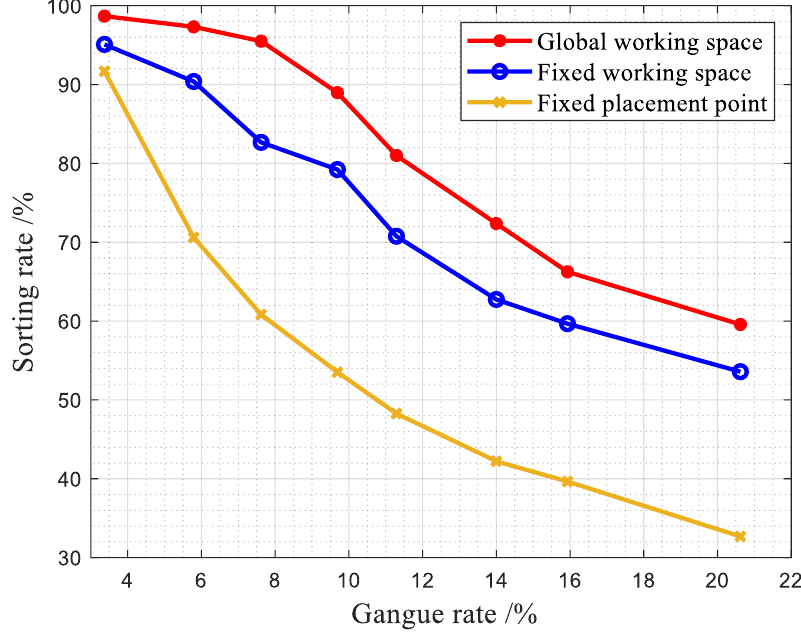
Figure 18. Sorting rate variation of the three sorting methods with different gangue contents.